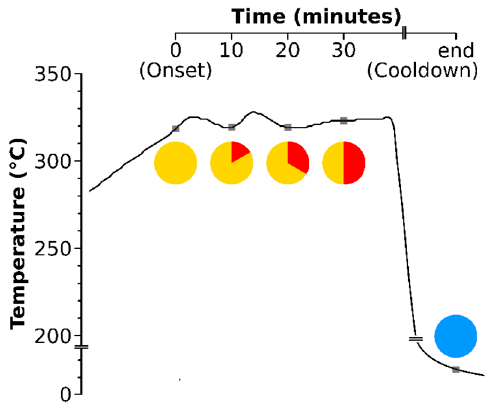
Figure A1. Temperature and aliquotation of the SPIONs sampling. The time points are graphically described by a yellow clock with a red display of the elapsed minutes since reaching 320 °C: onset (0 min), 10 min, 20 min, 30 min. The last time point (blue circle) represents the aliquot after cooldown.